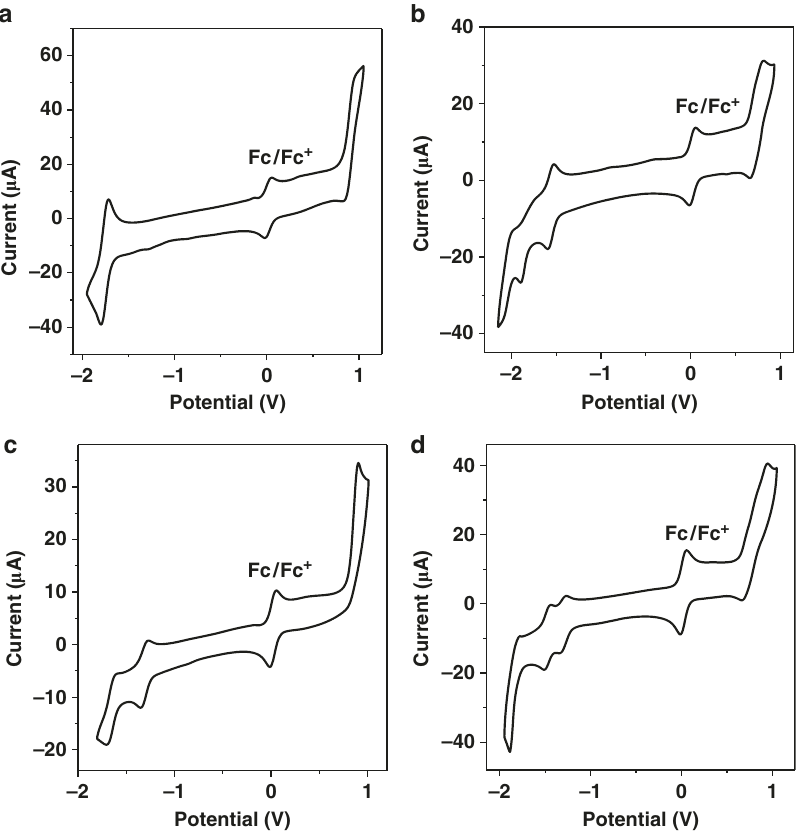
Fig. 4 Electrochemical study. Cyclic voltammograms of a Ir-1 , b Ir-2 , c Ir-3 , and d Ir-4 were determined in deaerated CH 3 CN/H 2 O (v/v, 9/1) solution, containing 0.5 mM photosensitizer, ferrocene, and 0.10 M Bu 4 NPF 6 as the supporting electrolyte, with a scan rate of 0.05 V/s − 1 and a negative initial scan direction. Glassy carbon electrode, Ag/AgNO 3 , and Pt silk were used as the working electrode, reference electrode, and counter electrode, respectively